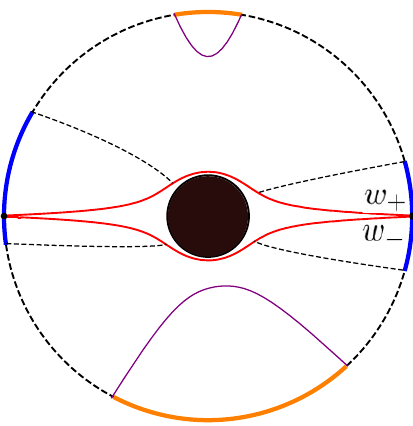
Figure 14 . Illustration of positions of subsystems which are in and out of equilibrium in the initial